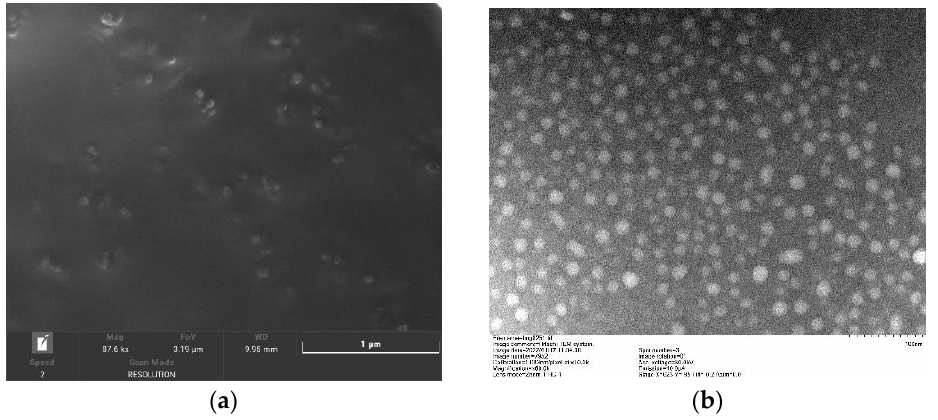
Figure 9. SLN-CA scanning electron microscope morphology ( a ), SLN-CA transmission electron microscope morphology ( b ).